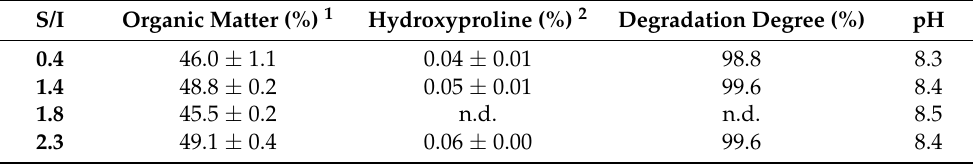
Table 3. Biomass characterization after digestion and degradation degree of hydroxyproline. S/I Organic Matter (%)